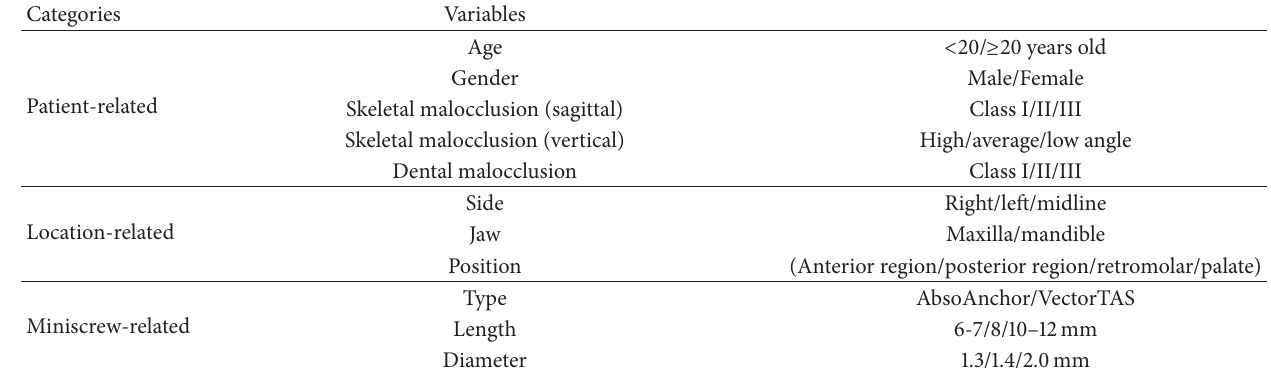
Table 1: Clinical variables